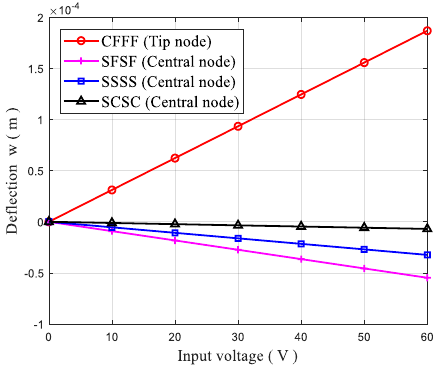
Figure 9. D eflection of a PFGP with different boundary conditions. Figure 9. Deflection of a PFGP with di ff erent boundary conditions.